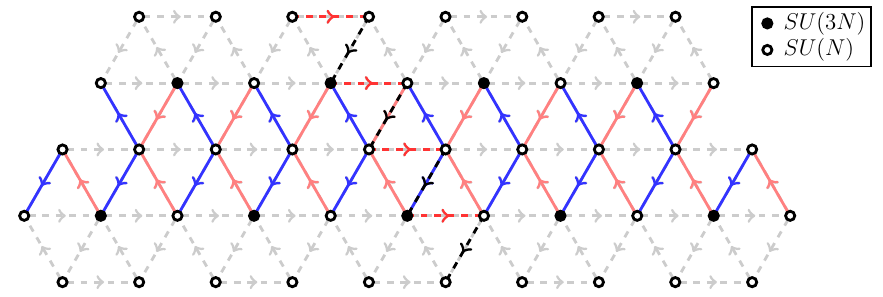
Figure 7 . An illustration of the quark charge assignments under the boundary-associated conserved global symmetries, using the chevron basis referred to in the text. In the main example the quark charges are indicated by the line color, blue and red for ± 1 charges. Quarks not charged under this U(1) are drawn with faint gray dashed lines. Solid and open circles at the nodes represent SU(3 N ) and SU( N ) groups. Every plaquette operator is neutral under this U(1) , and all of the SU( N c ) 2 U(1) mixed anomalies cancel for the gauge groups. As a counterexample, we also show an anomalous U(1) A as the zigzag line along the ϕ = 120 ◦ direction, with black and red dashed lines for ± 1 charges. This U(1) A is unbroken by W and the SU(3 N ) 2 U(1) A gauge anomaly; but, some of the SU( N ) 2 U(1) A anomaly coefficients are nonzero, so this U(1) A is broken explicitly by Λ N scale